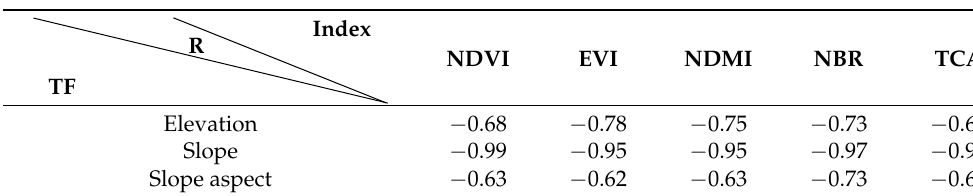
Table 9. Correlation between fusion accuracy and SHI.